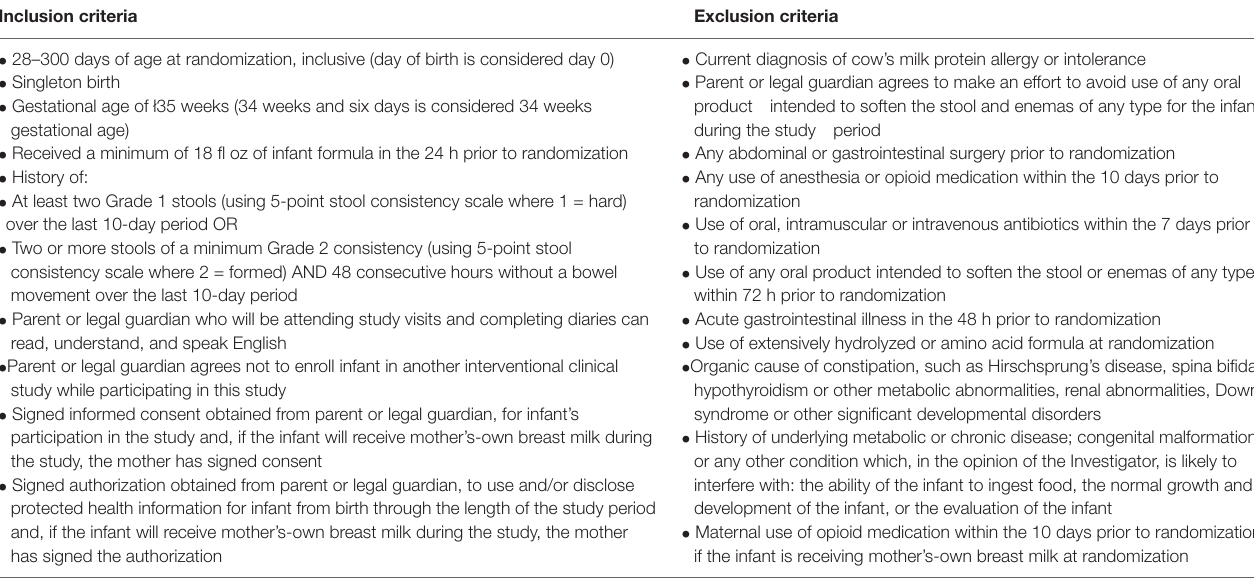
TABLE 1 | Participant inclusion and exclusion